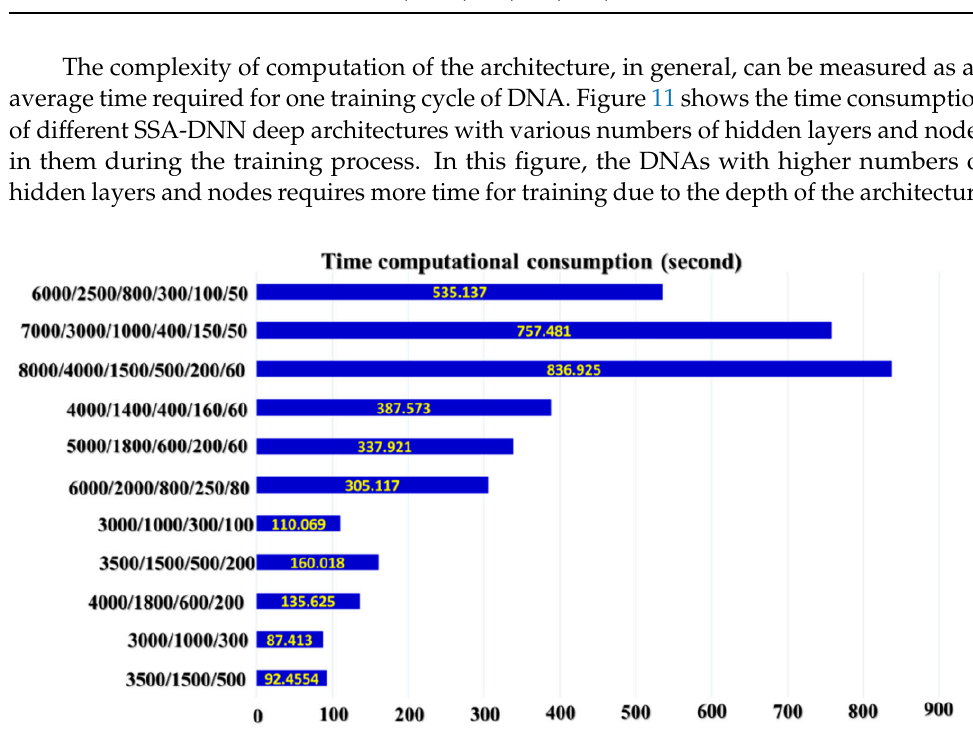
Figure 11. The training time consumption of SSA-DNN architectures with different numbers of hidden layers and nodes in